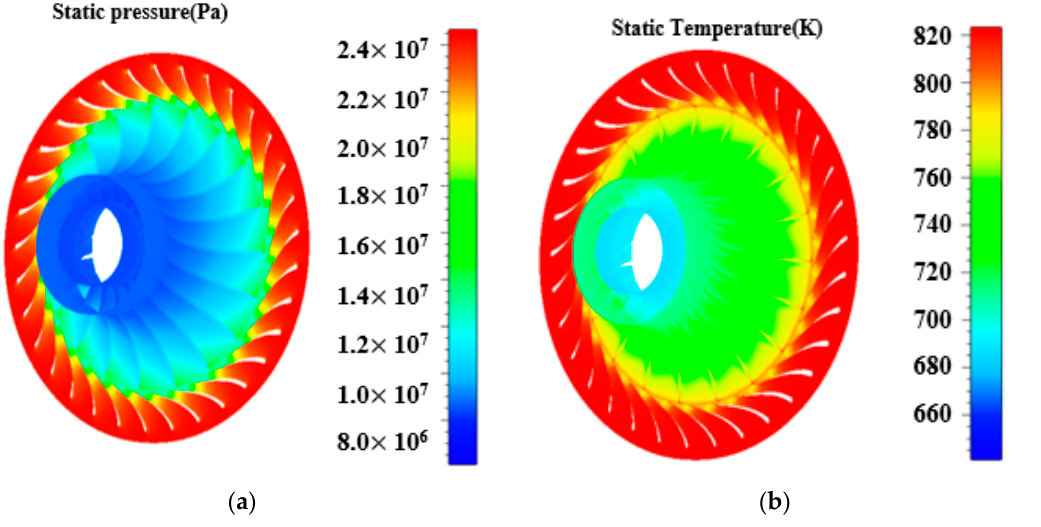
Figure 7. Contours of static pressure and temperature at 50% blade span. ( a ) Static pressure; ( b ) static temperature.